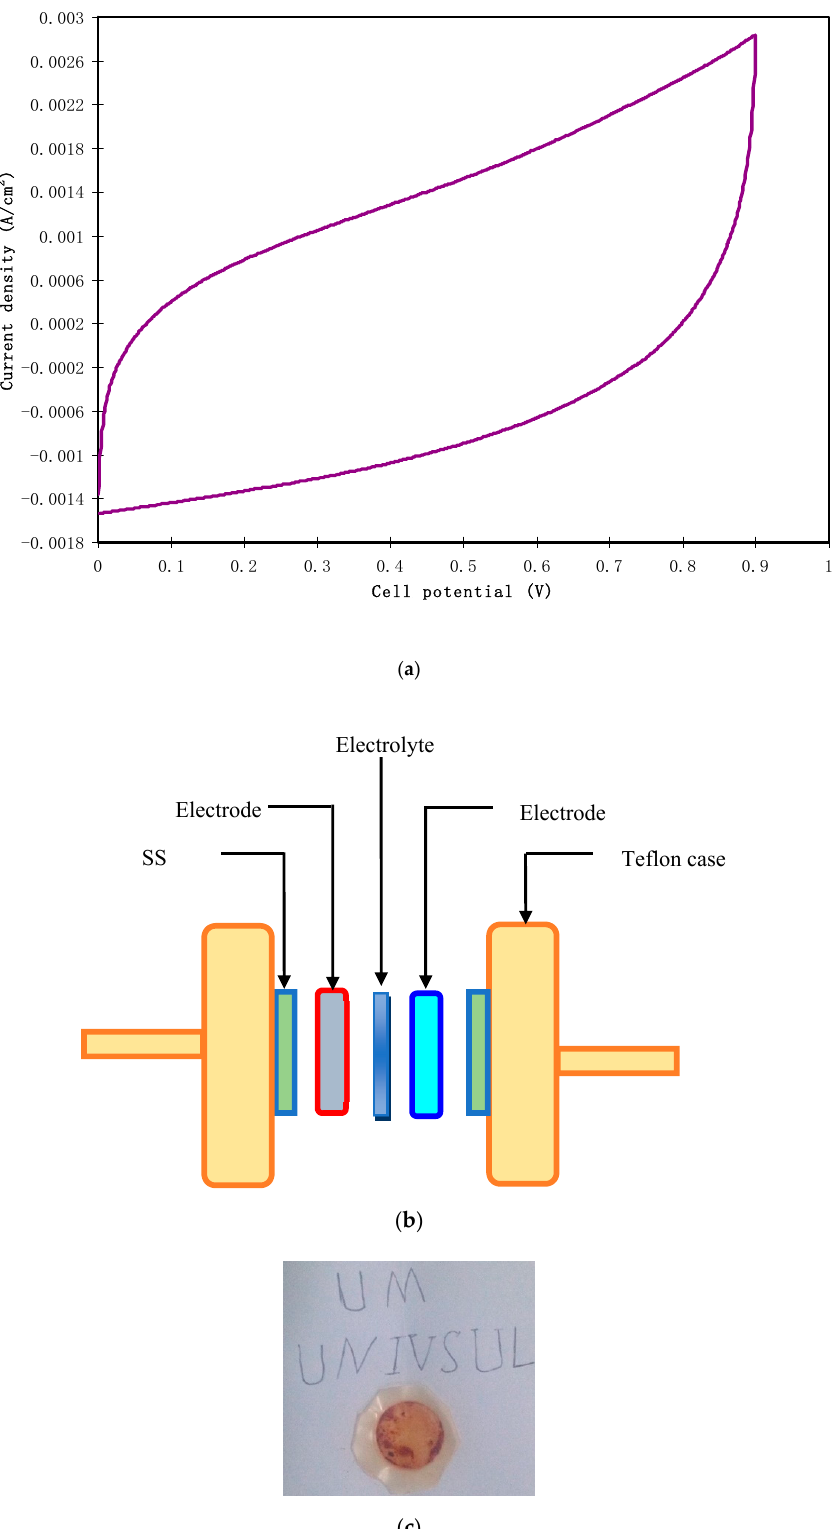
Figure 11. ( a ) CV measurement for the highest conducting SPE at 10 mV / s from 0 to 0.9 V, ( b ) schematic diagram of the CV measurement unit for the fabricated electric double-layer capacitor (EDLC) cell, and ( c ) realist image of the highest conducting SPE when reaching the breakdown